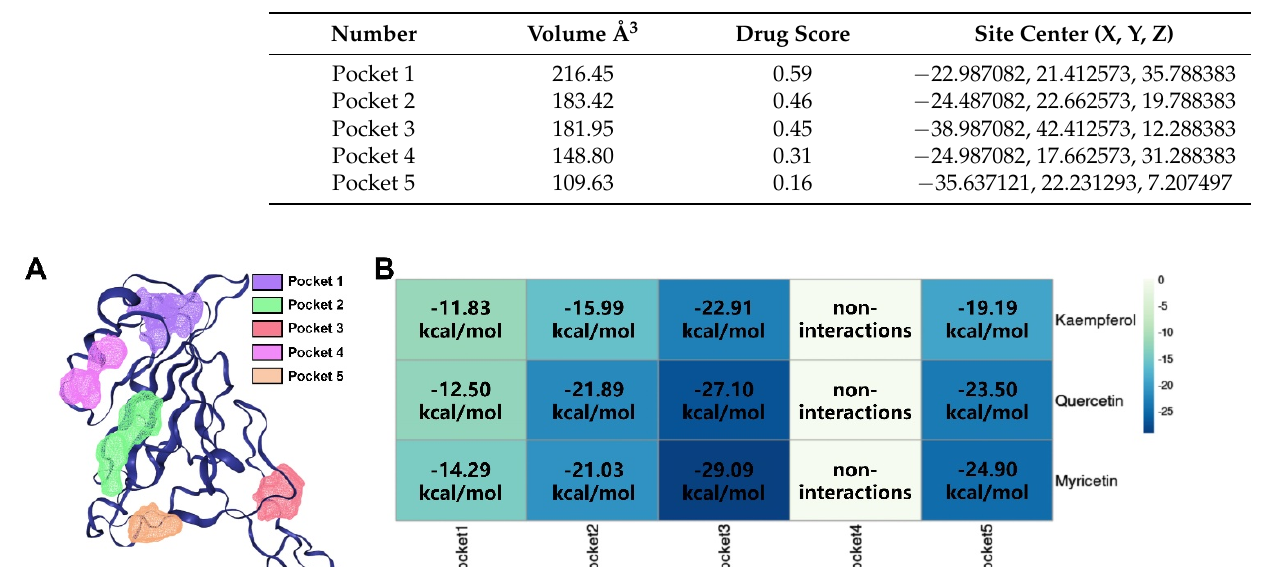
Table 2. The parameters of possible druggable binding sites identified by DoGSiteScorer.